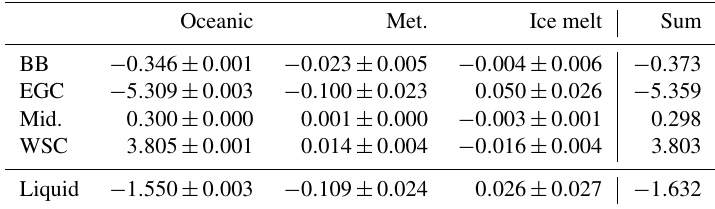
Table 11. Mean volume fluxes (Sv ± standard deviation) for the components of the Fram Strait flux (Belgica Bank, BB; East Greenland Current, EGC; mid-strait, Mid.; West Spitsbergen Current, WSC) for a three-end-member model with seawater salinity and δ 18 O fixed at 35.0 and 0.35‰ respectively. Positive values indicate fluxes into the Arctic. Oceanic